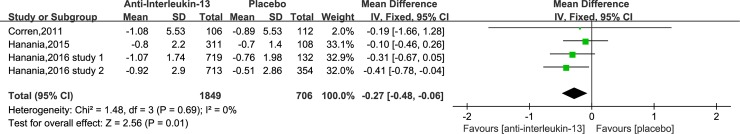
Forest plot comparing anti-IL-13 and placebo with rescue medication use.